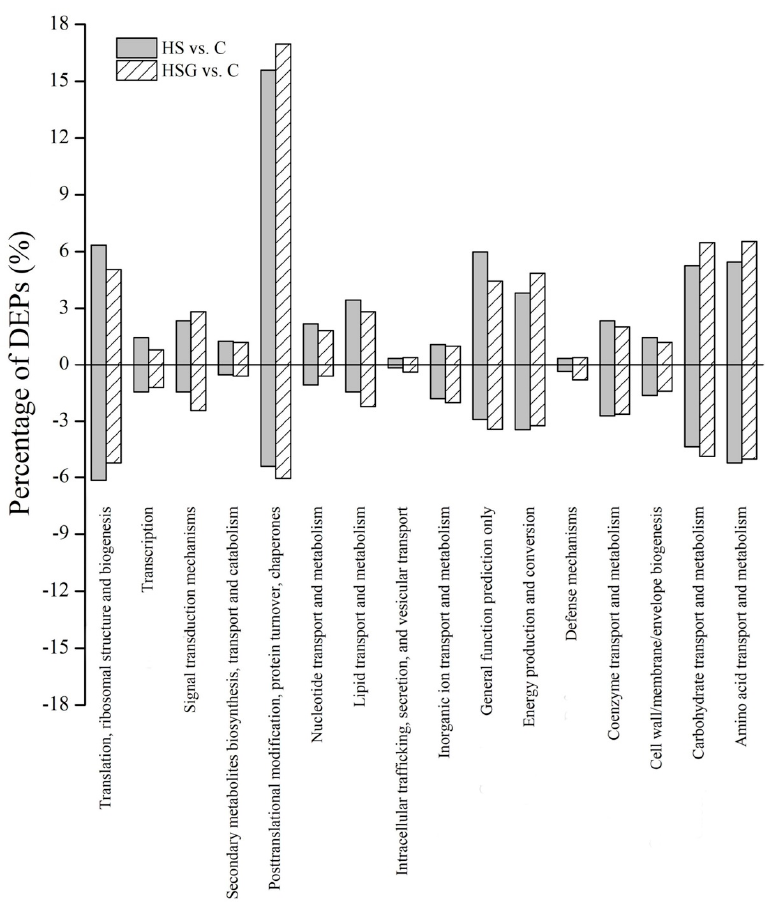
Figure 7. Kyoto Encyclopedia of Genes and Genomes (KEGG) analysis of identified differentially expressed proteins (DEPs) in leaf of creeping bentgrass in response to exogenous γ -aminobutyric acid (GABA) and heat stress. C, control (normal condition); HS, heat stress; HSG, heat-stressed plants pretreated with GABA.